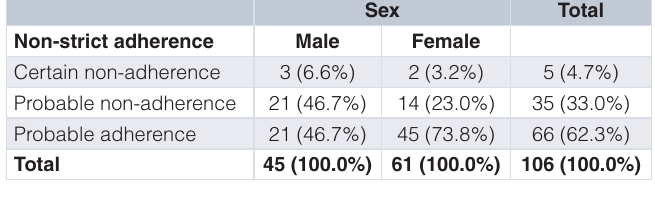
Table 8. Univariate analysis of sex and strict adherence (all categories), Pearson χ 2 = 8.91, P = 0.031 (Fishers exact P = 0.026). Strict